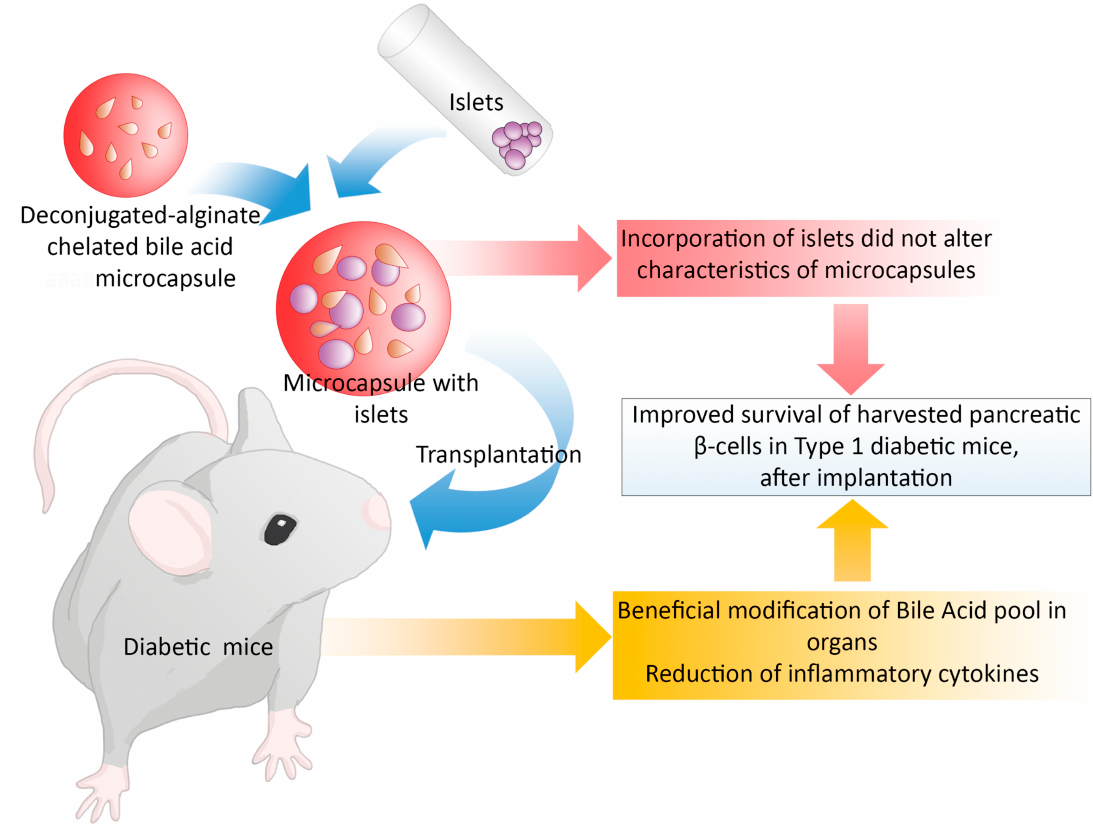
Figure 6. Summery figure of the study design; transplanted experimental microcapsules formed from incorporating islet with polymers and bile acids reduced inflammatory cytokines in vivo.